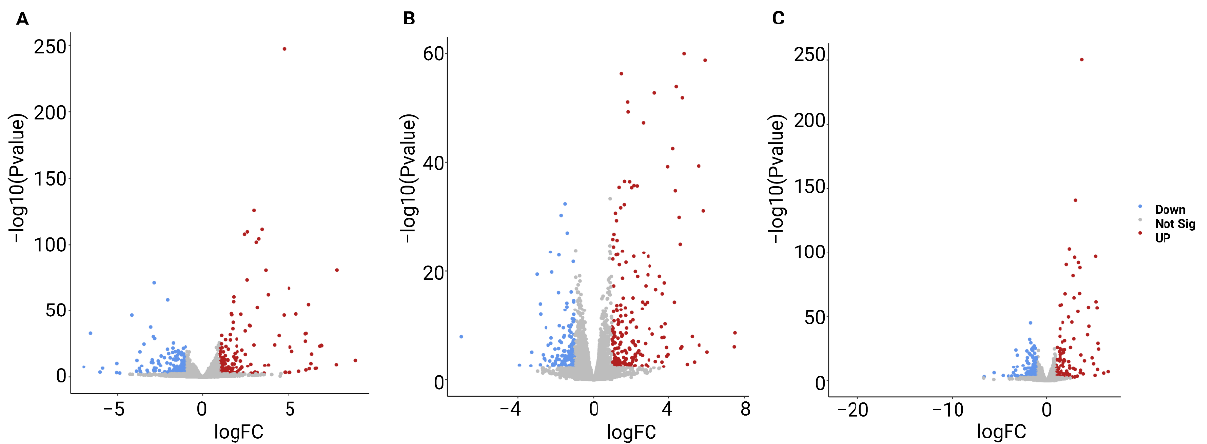
Figure 6. Volcano plot showing the differentially expressed genes (DEGs) from ( A ) Col-0, ( B ) Cvi-0, and ( C ) U112-3. Blue dots represent downregulated genes, and red dots represent upregulated genes; grey dots are not significantly up- or downregulated.